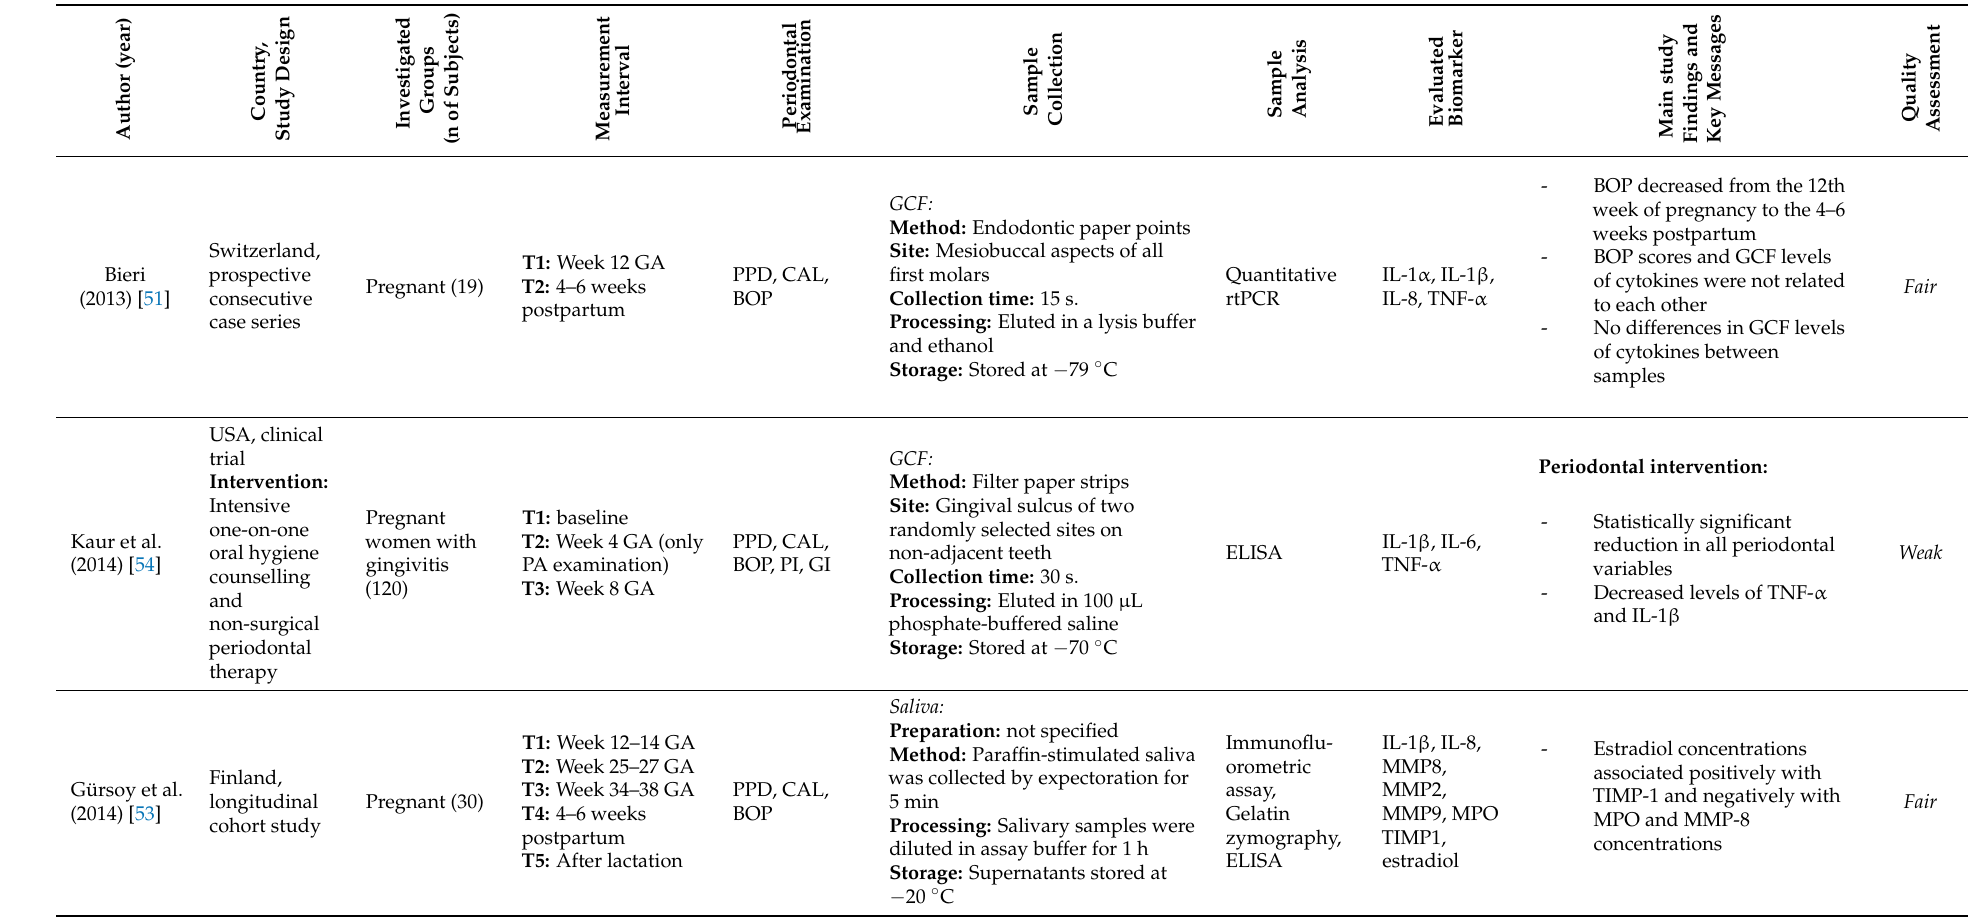
Table 3. Differences in the response of inflammatory biomarkers in oral biofilm between pregnancy